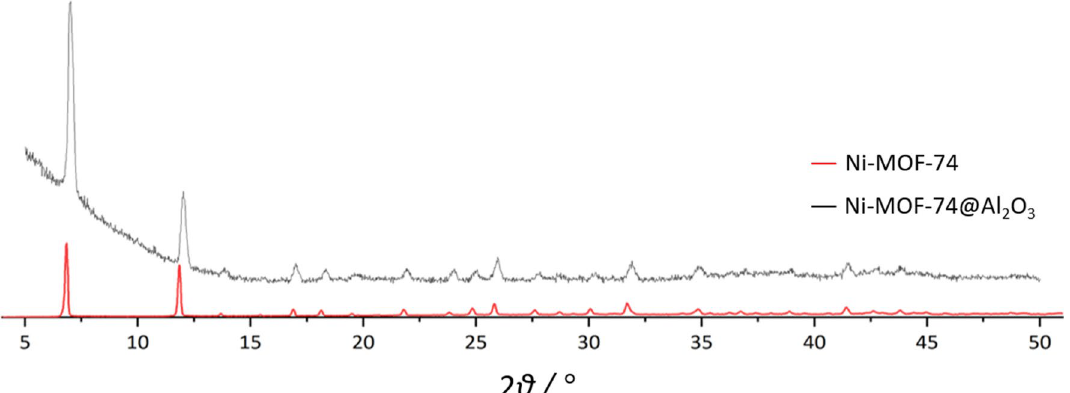
Fig. 2 XRD pattern of Ni-MOF-74 (red) and the Ni-MOF-74@Al